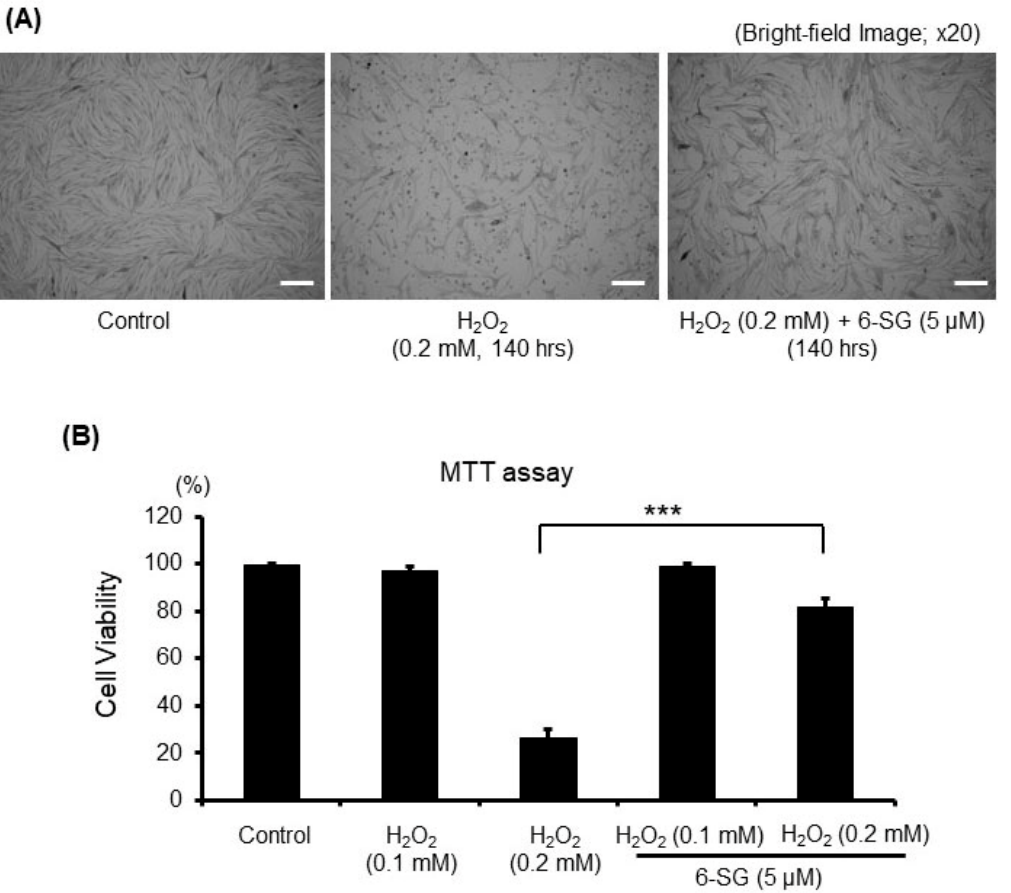
Figure 1. Viability of cultured human epidermal melanocytes after exposure to the indicated treatment with ^6-Shogaol (6-SG) for 140 h. ( A ) Cultured cell observation under bright-field microscopy; ( B ) Cell viability evaluation by MTT assay. White bar in (A), 50 µm. Data in (B) represent the results of three independent experiments. Data are shown as mean ± SD. ***, p < 0.01.